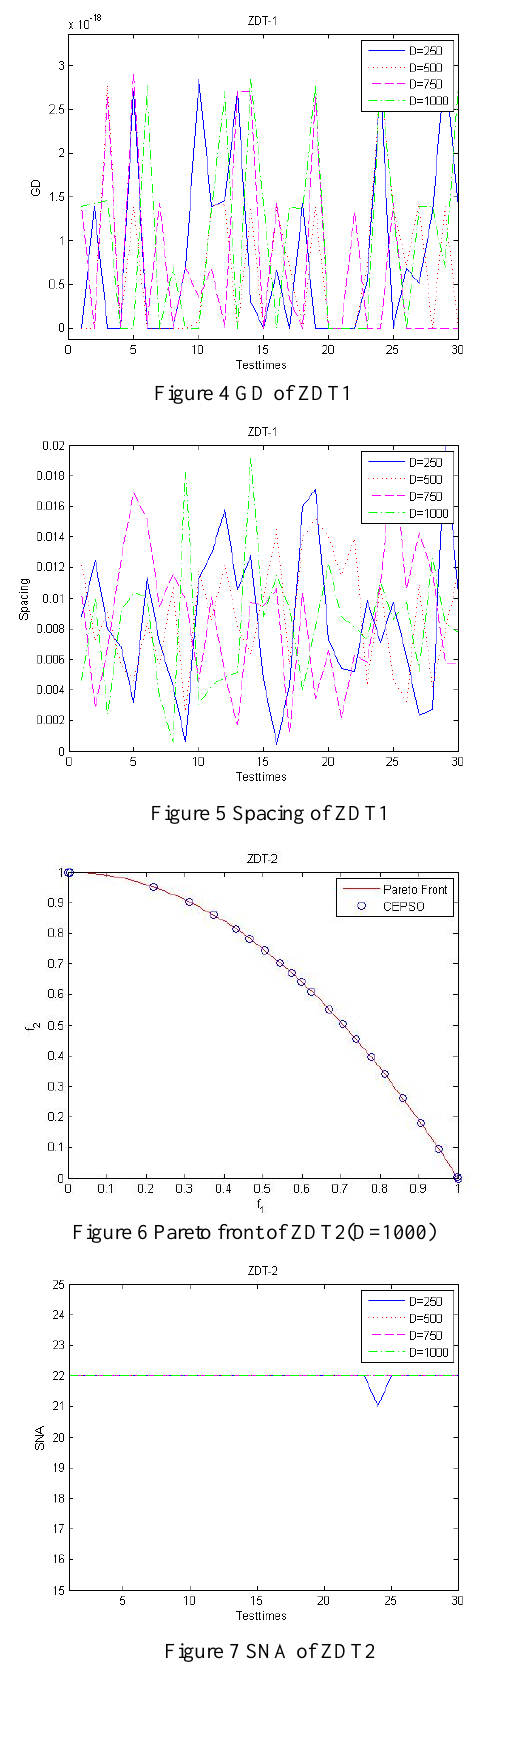
Figure 4 GD of ZDT1 Figure 8 GD of ZDT2